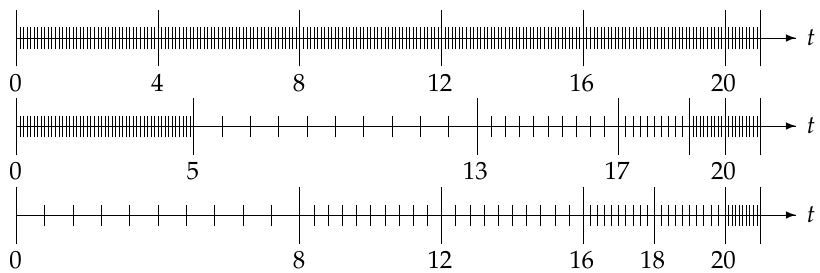
Figure 1. Full mesh ( top ) and nested meshes proposed in [33] ( center ) and in [34] ( bottom ). The meshes are shown for the time instant t = 21 and the basic step size h =